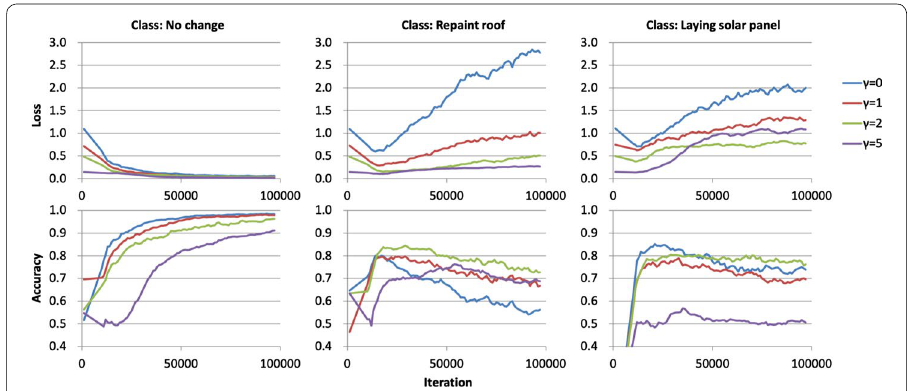
Fig. 4 Focal loss and building change detection